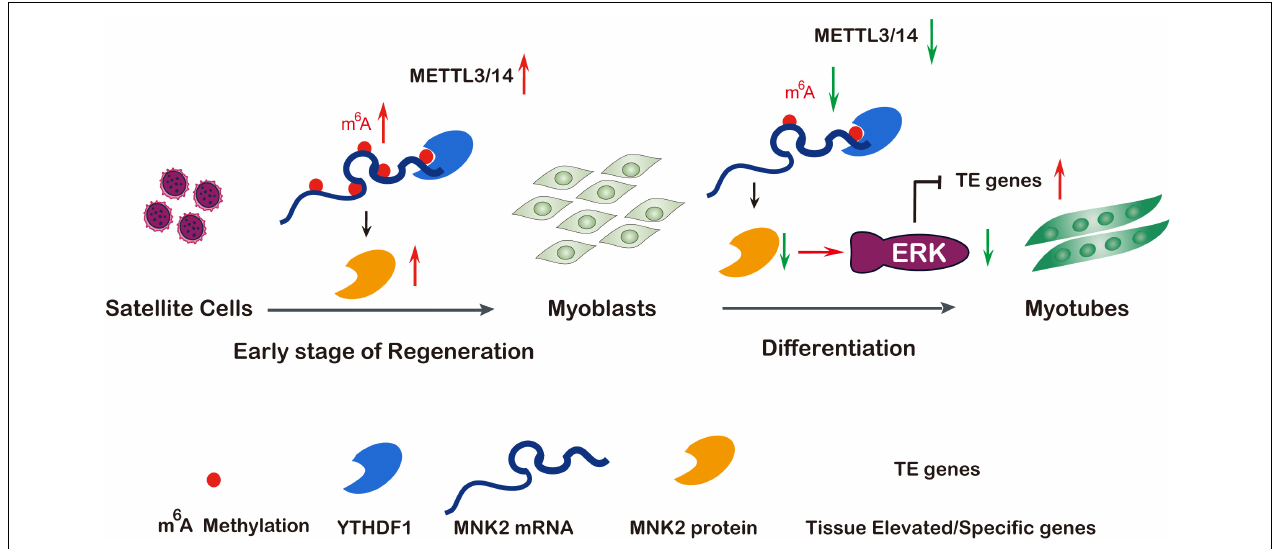
FIGURE 7 | A model of METTL3/14 target MNK2 via m 6 A modification and then modulate ERK signaling pathway during skeletal muscle differentiation and regeneration. Tissue renewal and muscle regeneration largely rely on the activation and proliferation of muscular satellite cells, the expression of METTL3 and METTL14 is increased on the early stage of regeneration after injury, then promotes MNK2 expression and favors to accelerate regeneration. In differentiating myoblasts, m 6 A modification and core methyltransferases METTL3 and METTL14 are down-regulated, METTL3/14 target MNK2 directly then regulate ERK signaling to block myogenesis, so decreased expression of METTL3/14 is essential for skeletal muscle differentiation. Additionally, the m 6 A modified Mnk2 is recognized by